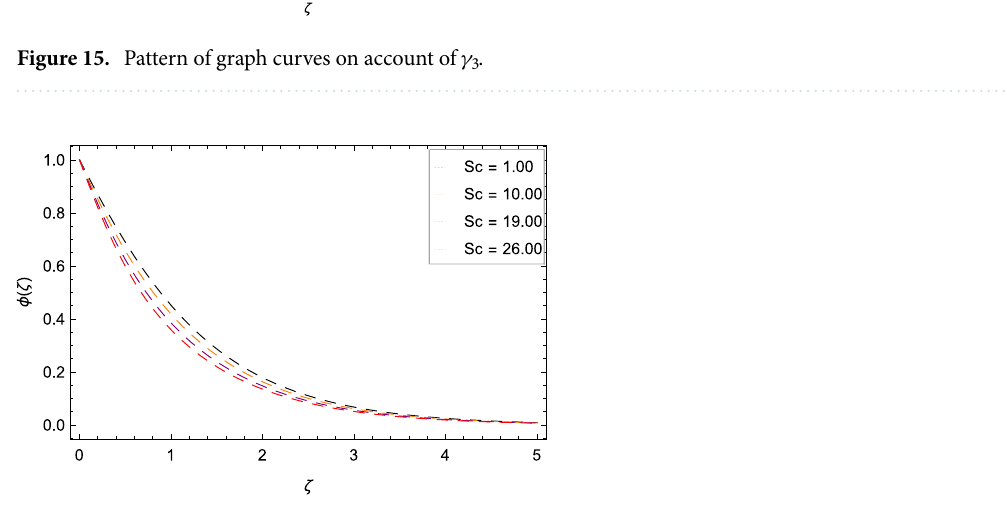
Figure 16. Pattern of graph curves on account of Sc